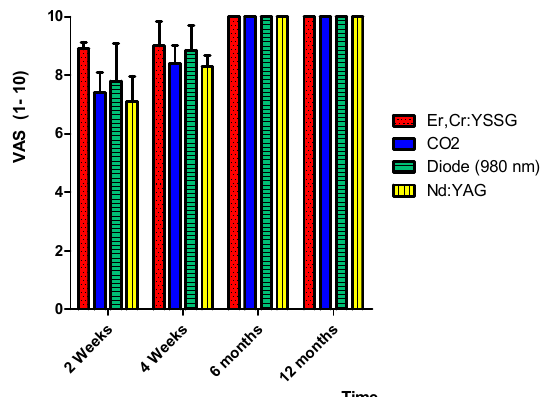
Figure 10. Visual analogue scale of patient satisfaction at different follow-ups. Zero represents the worst satisfaction possible and 10 represents the highest satisfaction possible.